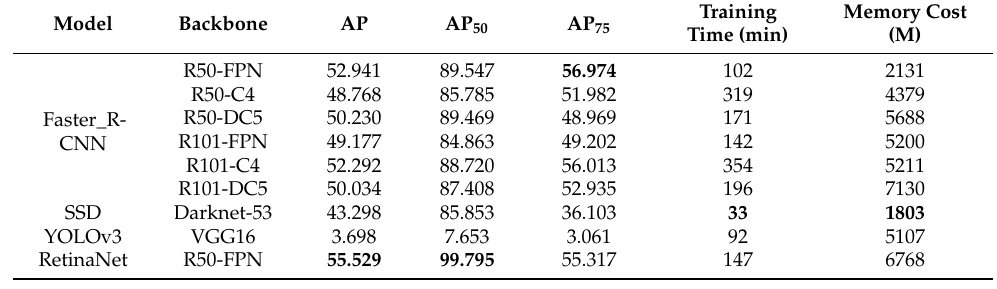
Table 3. Oil well detection average precision (AP) of nine state-of-art algorithms. The bold font indicates the best performance.